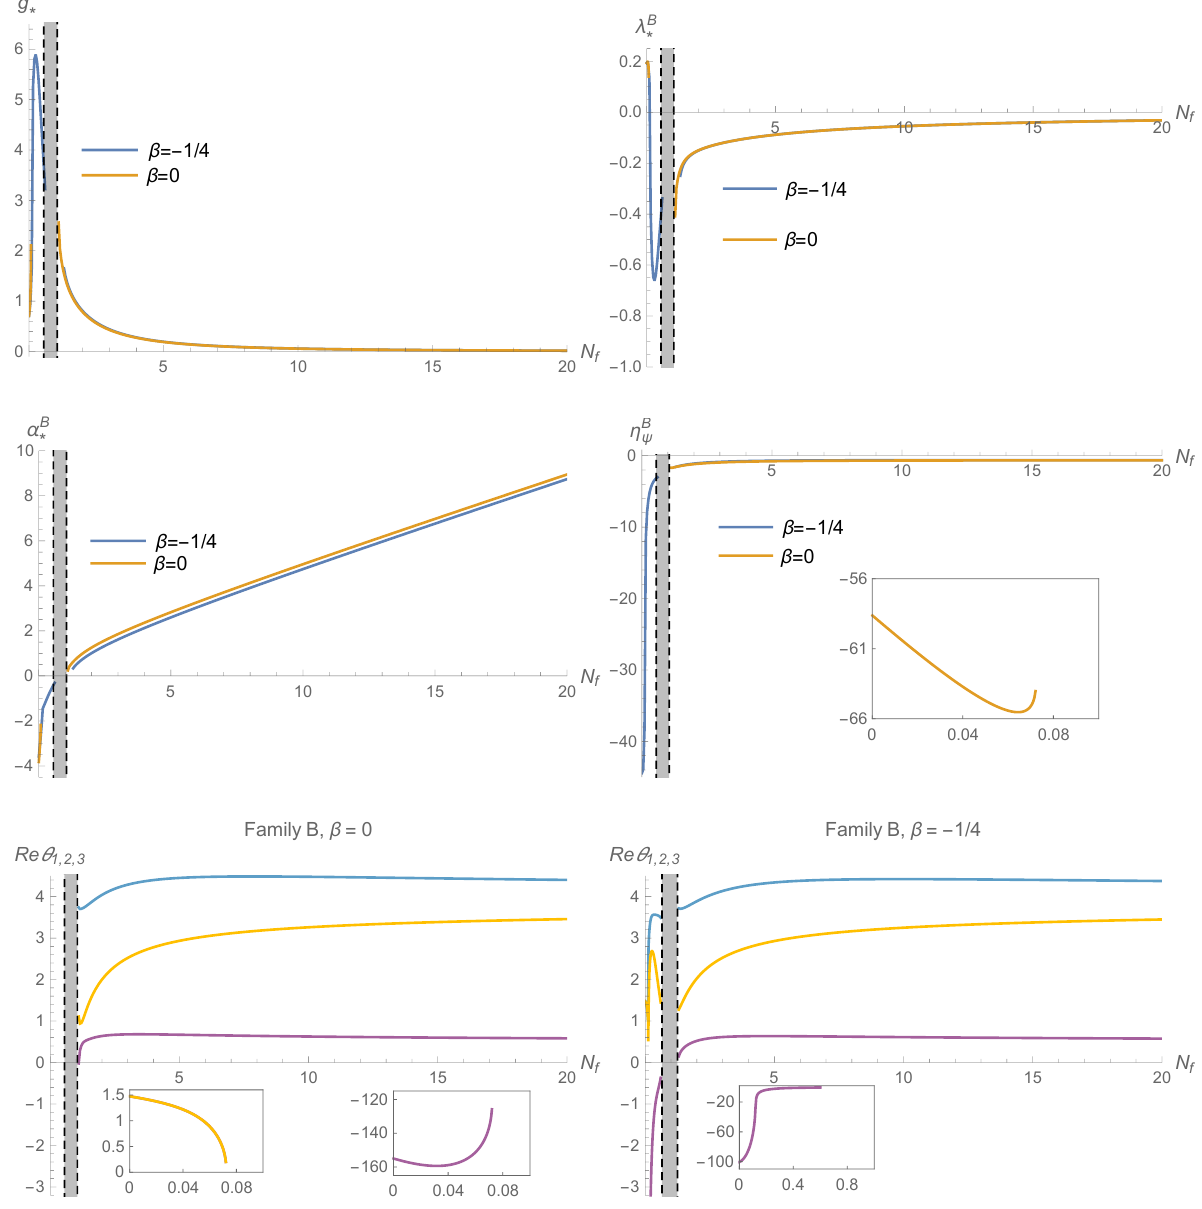
Figure 9. Results from the numerical investigation of the fixed points belonging to Family B . The first three diagrams show the position of the fixed points as a function of N f for β = − 1/4 (blue line) and β = 0 (orange line). The fixed points exist for all values N f outside the window (55). The fermion anomalous dimension evaluated at the fixed point is depicted in the < 0 in all cases. Notably, small values of N | η ∗ | fourth diagram, indicating that η ∗ f lead to rather large absolute values ψ ψ ≈ − 1 (cf. Table 3). The stability coefficients show that the while values N f to the right of the region of instability have η ∗ N NGFP B are saddle points with two UV-relevant directions (three UV-attractors) for values N f below (above) the bounds (55). The inserts magnify the fermion anomalous dimension and the stability coefficients obtained for the NGFP B along the orange line in Figure